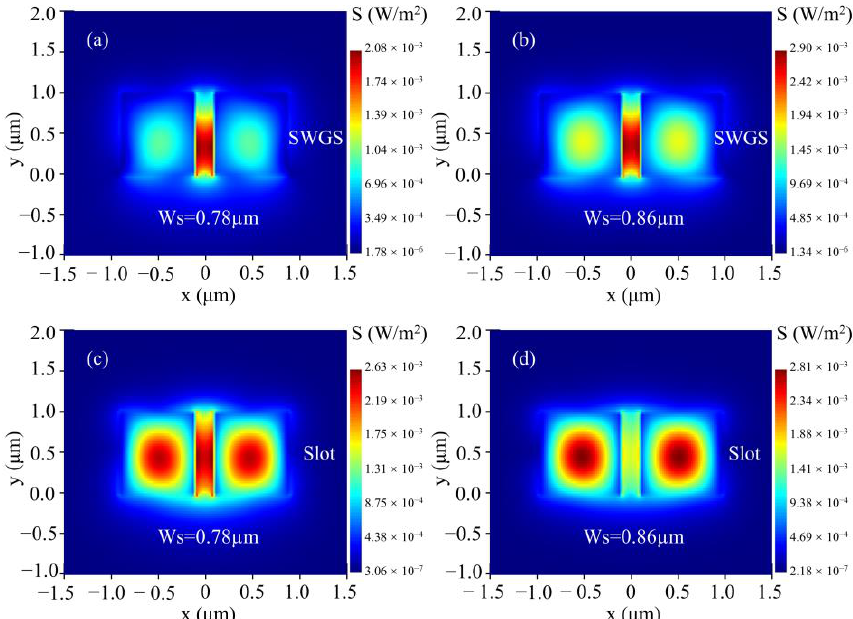
Figure 4. The distribution of the Poynting vector on the cross-section for SWGS waveguide when Ws is ( a ) 0.78 µm; ( b ) 0.86 µm; for slot waveguide when Ws is ( c ) 0.78 µm; ( d ) 0.86 µm.